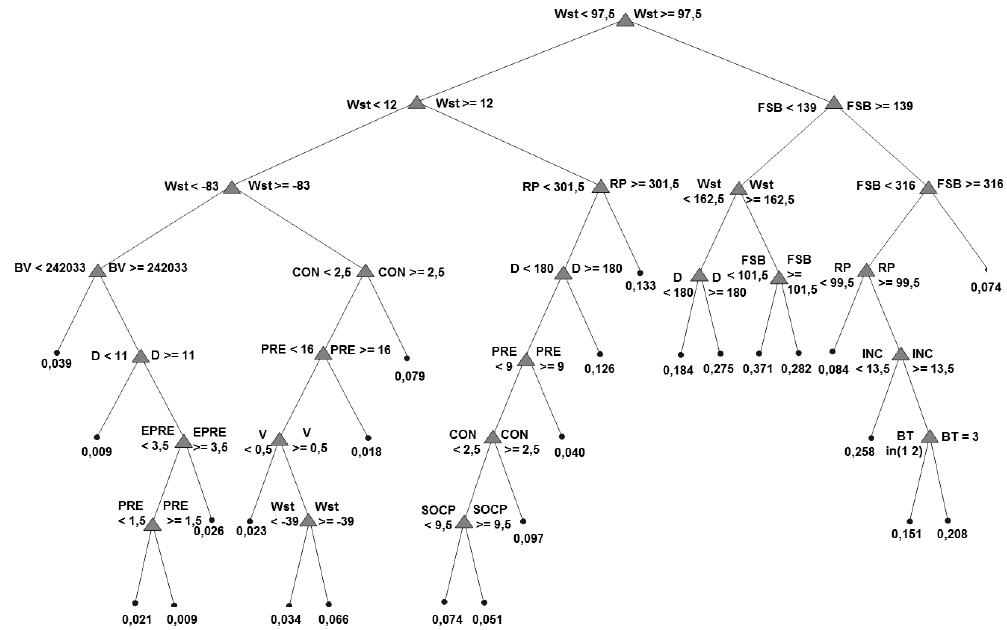
Fig. 3. Regression tree RT1 with 25 leaves for estimating building loss ratio (wst: water depth [cm]; fsb: floor space of building [m 2 ]; rp: return period [yr]; bv: building value [C]; con: contamination indicator [ − ]; pre: precautionary measures indicator [ − ]; inc: monthly net income [ − ]; epre: perception of efficiency of private precaution [ − ]; socp: socio-economic status [ − ]; bt: building type [ − ]). Terminal node values give the average loss ratio of all data values of the terminal